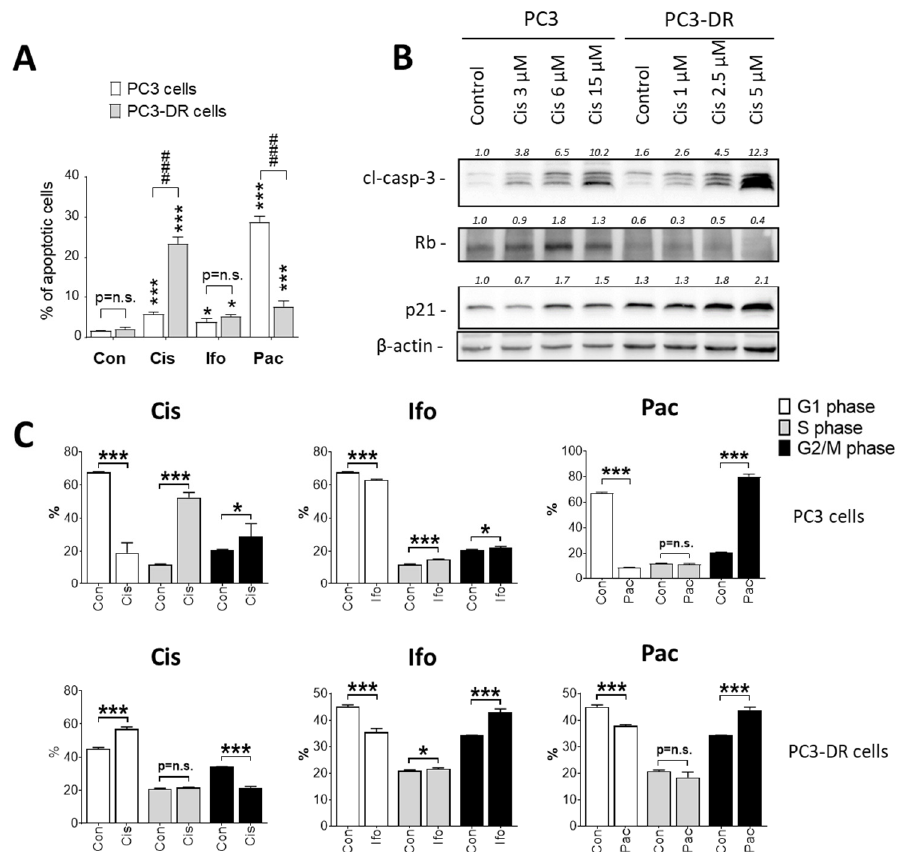
Figure 6. Effects of the individual drugs on cell cycle progression. DNA fragmentation ( A ) and cell cycle progression ( C ) in PC3 and PC3-DR cells were accessed using flow cytometry technique and propidium iodide (PI) staining. Cells were treated with Cis (10 µM), Ifo (5 mM), or Pac (250 nM) for 48 h, harvested, fixed, stained with PI, and analyzed. Cells that appeared in the sub-G1 population were assumed as apoptotic ( A ). ( B ), Protein expression was measured in the drug-treated cells using Western blotting. In all the experiments, cells were treated with the drugs for 48 h. Statistical analysis: difference between the sample and control: * p < 0.05; *** p < 0.001 (ANOVA); difference between two samples: ### p < 0.001 ( t -test).